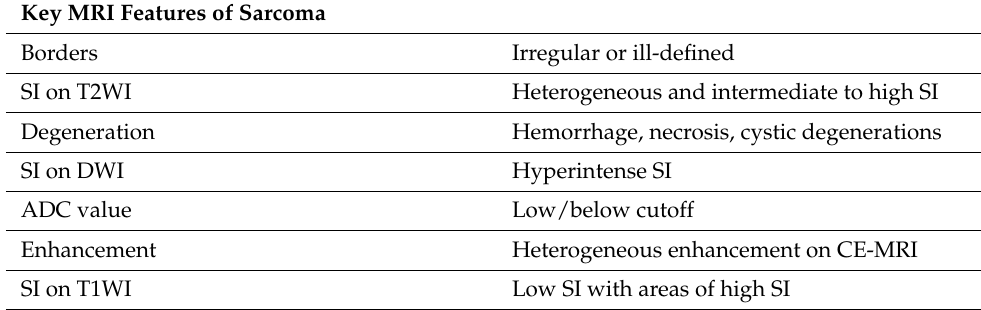
Table 4. Key features of sarcoma on